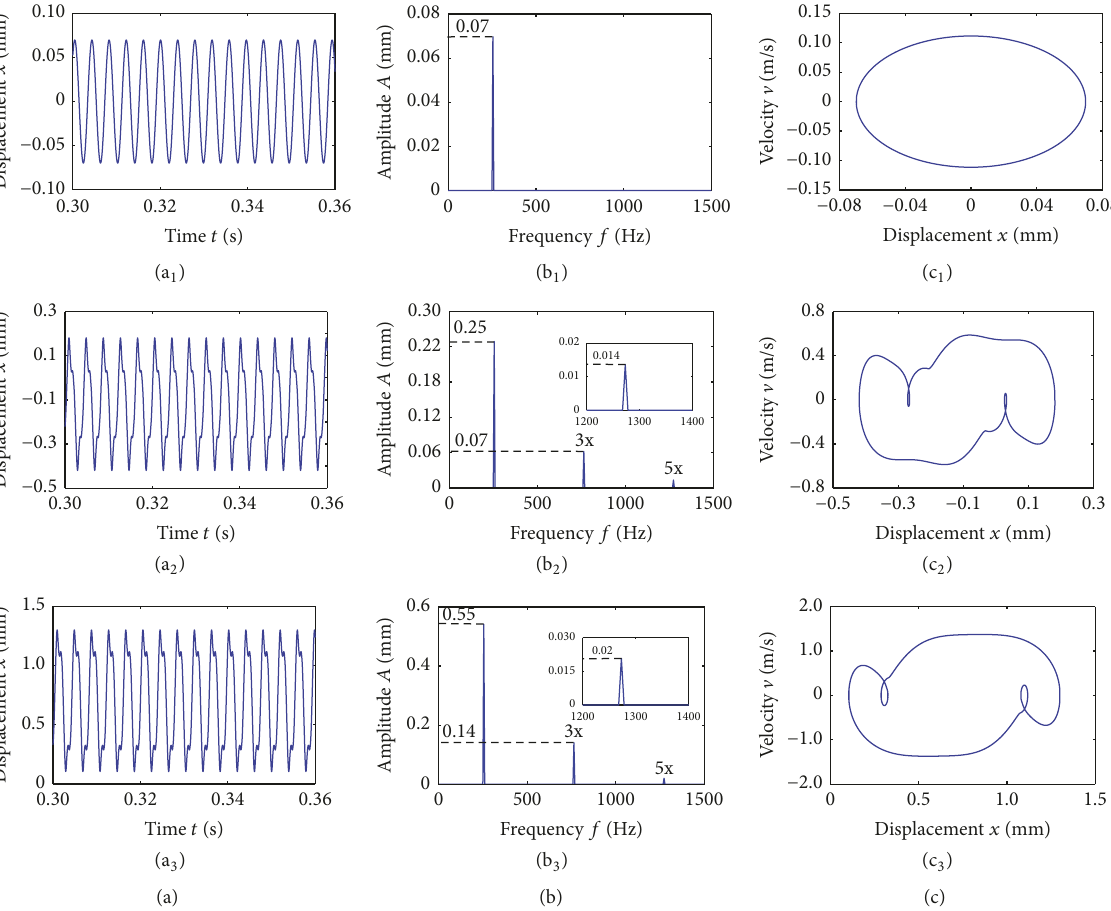
Figure 10: The responses of blade-root at different excitation amplitudes ((a) is the time-domain response, (b) is the frequency spectrum, and (c) is the phase